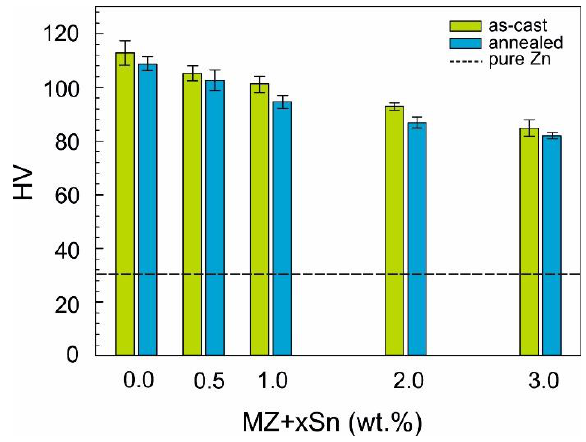
Figure 11. HV1 microhardness of the investigated